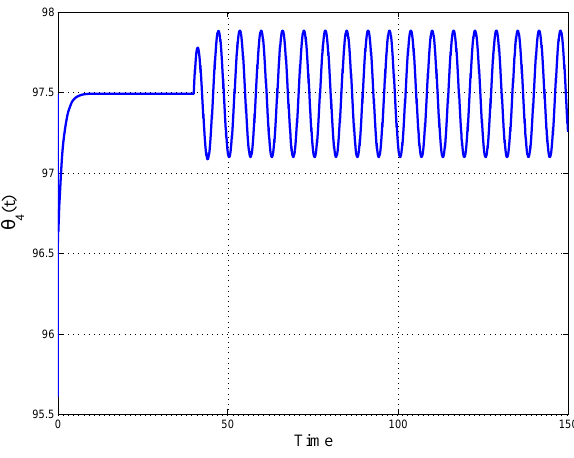
Figure 12. Generic time history for θ 4 ( t ) .